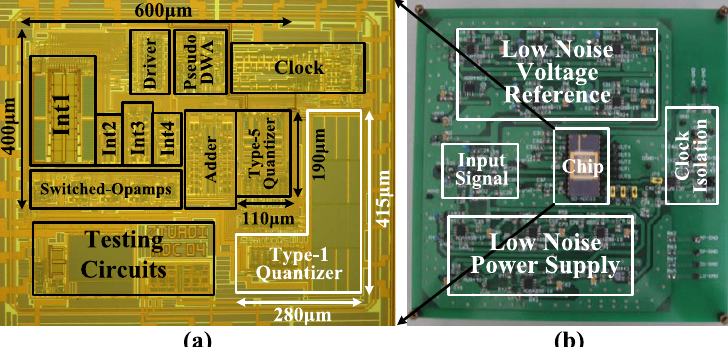
Figure 15. ( a ) Chip photo of the proposed Delta-Sigma modulator; ( b ) Circuit testing board.